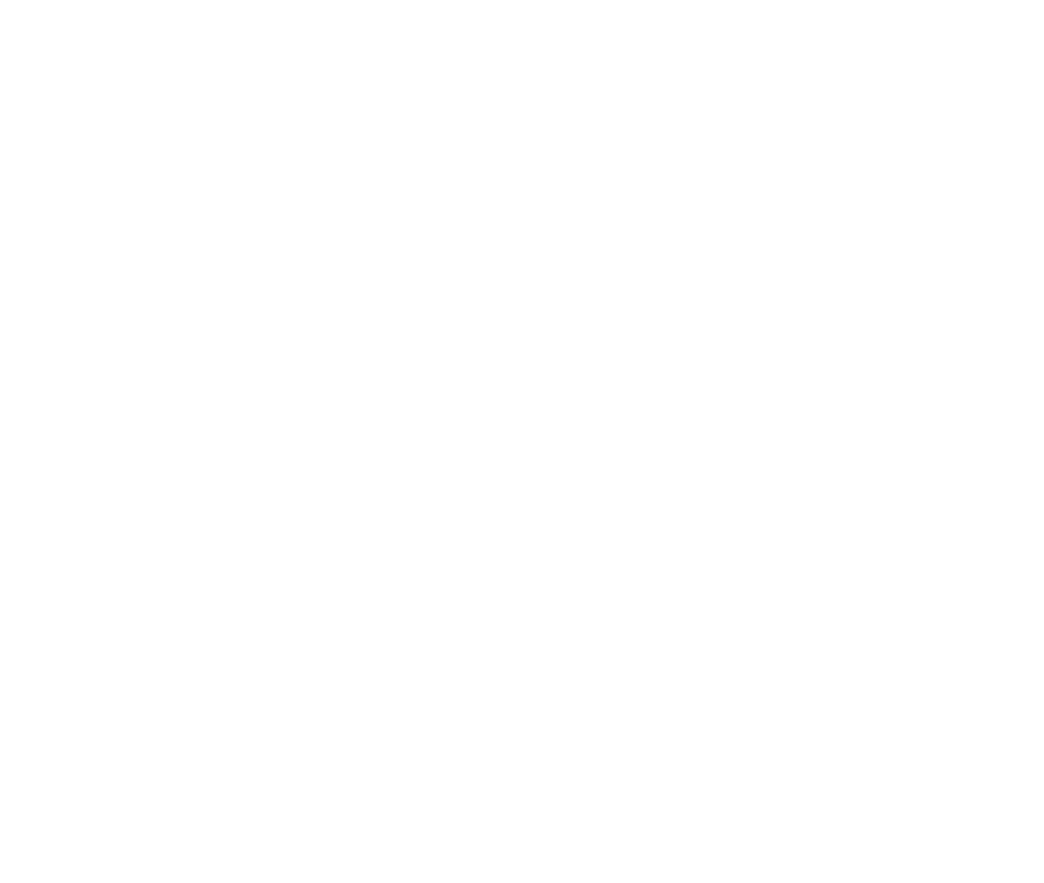
Risk of surgical site infection by timing of surgical antimicrobial prophylaxis. The lowest risk of surgical site infection was observed when the antibiotics were administered between 74 and 30 minutes before